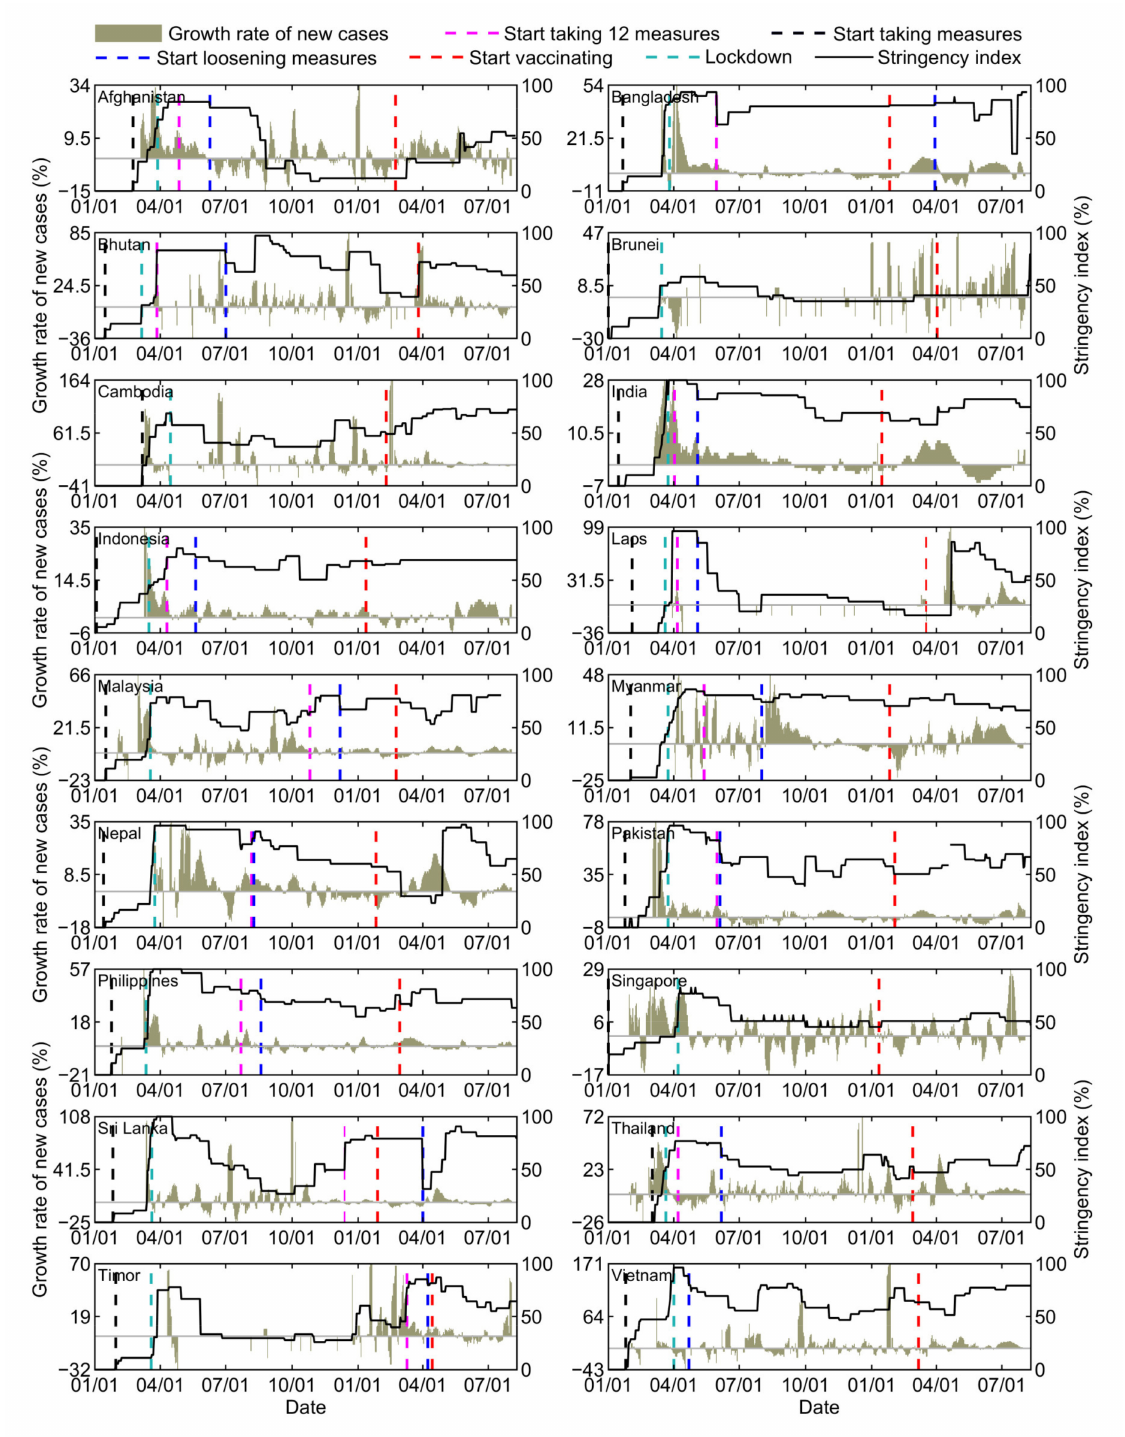
Figure A1. Relationships between the growth rate of new cases and stringency index in South and Southeast Asia (except Maldives, due to data